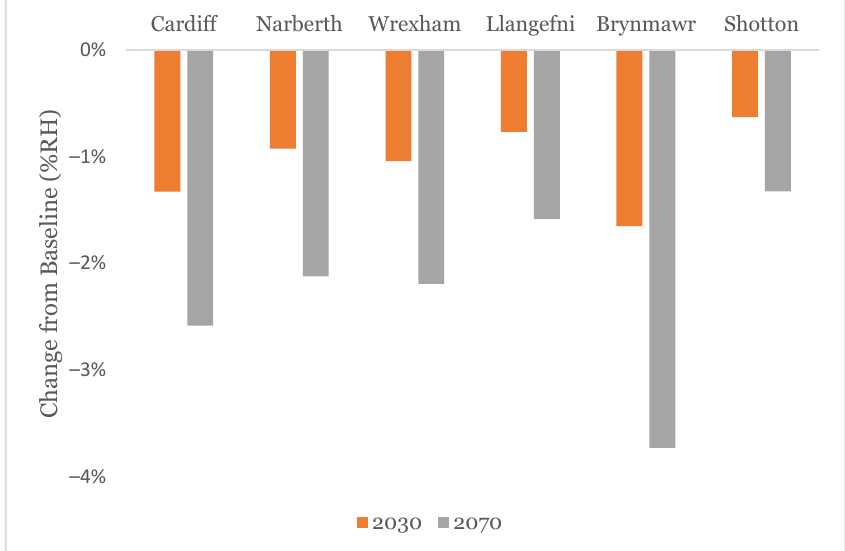
Figure 7. Change in average daily outdoor relative humidity for 2030 and 2070. Precipitation trends exhibit a more varied set of projections by location and time period. In general, the wettest times of year across all locations are the colder months, as seen in Figure 8 for Cardiff. Looking forward to 2030 and 2070, the colder months are projected to see an increase in precipitation, while the warmer months are projected to see a decrease in precipitation. However, on an annual scale, the trends are not as unanimous across locations as they are for the other climate variables. Cardiff, Narberth, Llangefni, and Brynmawr are projected to experience an increase in annual precipitation by 2030 and then another increase by 2070 (Figure 9). Conversely, in 2030, Wrexham is projected to see 0.7% more annual precipitation than baseline, but 1.7% less annual precipitation than baseline come 2070. Furthermore, Shotton’s annual precipitation is projected to stay close to baseline levels for both projections, with a 0.6% increase from baseline by 2030, followed by a drop to 0.2% above baseline by 2070 (Figure 10).